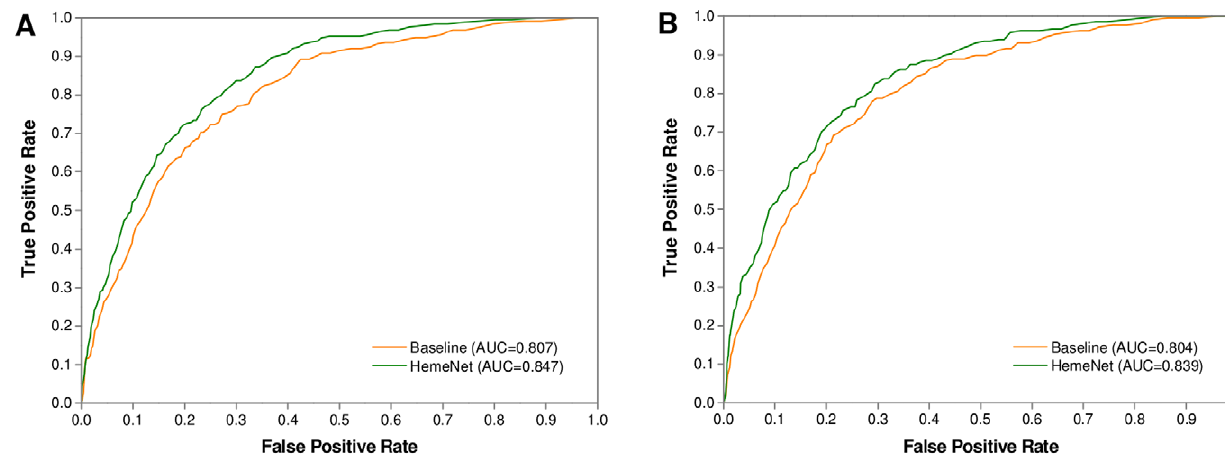
Figure 6. The ROC curves of baseline model and HemeNet tested on Dataset 4. (a) Holo structures; (b) Apo structures.